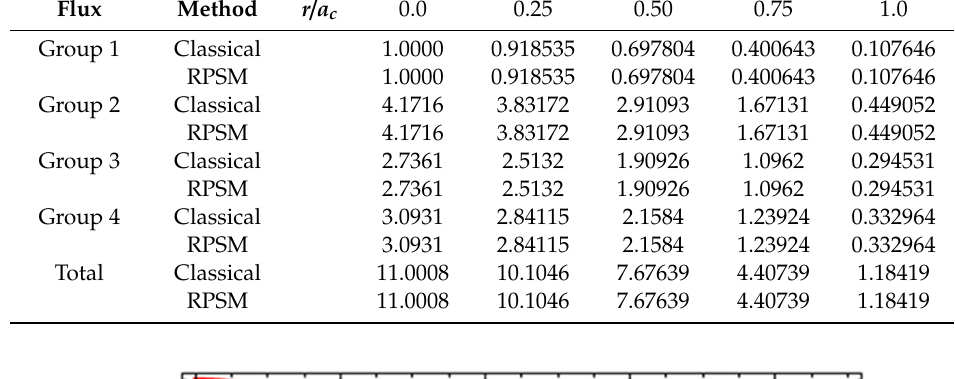
Table 12. The four groups fluxes and total flux in spherical reactor geometry.